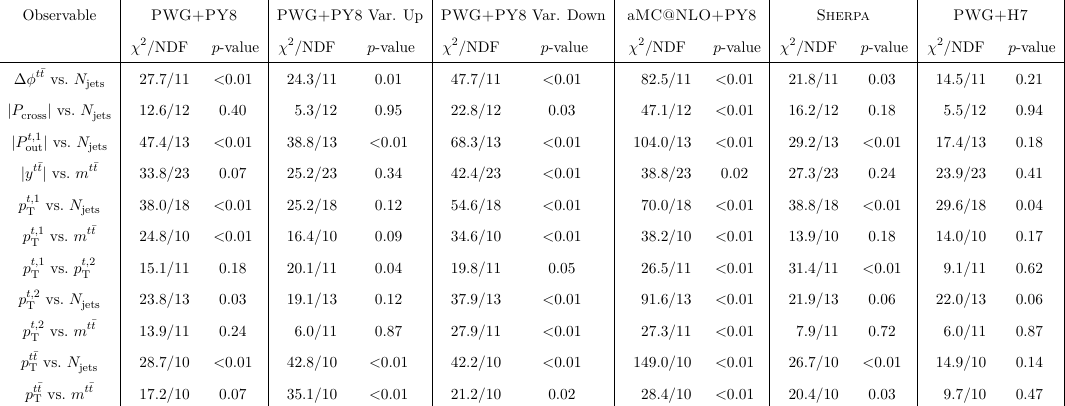
Table 11 . Comparison of the measured particle-level normalised double-differential cross-sections with the predictions from several MC generators. For each prediction, a χ 2 and a p -value are calculated using the covariance matrix of the measured spectrum. The number of degrees of freedom (NDF) is equal to the number of bins in the distribution minus